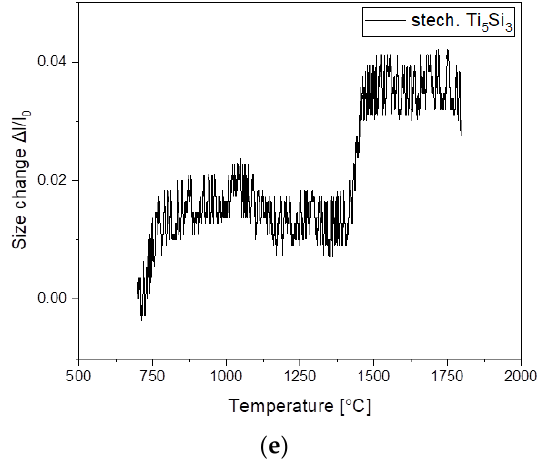
Figure 2. Dilatometric curves of the composite sintering process at a temperature of 2250 °C. ( a ) commercial B 4 C, ( b ) B 4 C +%TiSi 2 , ( c ) B 4 C +%Ti 5 Si 3, ( d ) B 4 C + stochiometric additive TiSi 2 , ( e ) B 4 C + stochiometric additive Ti 5 Si 3 .